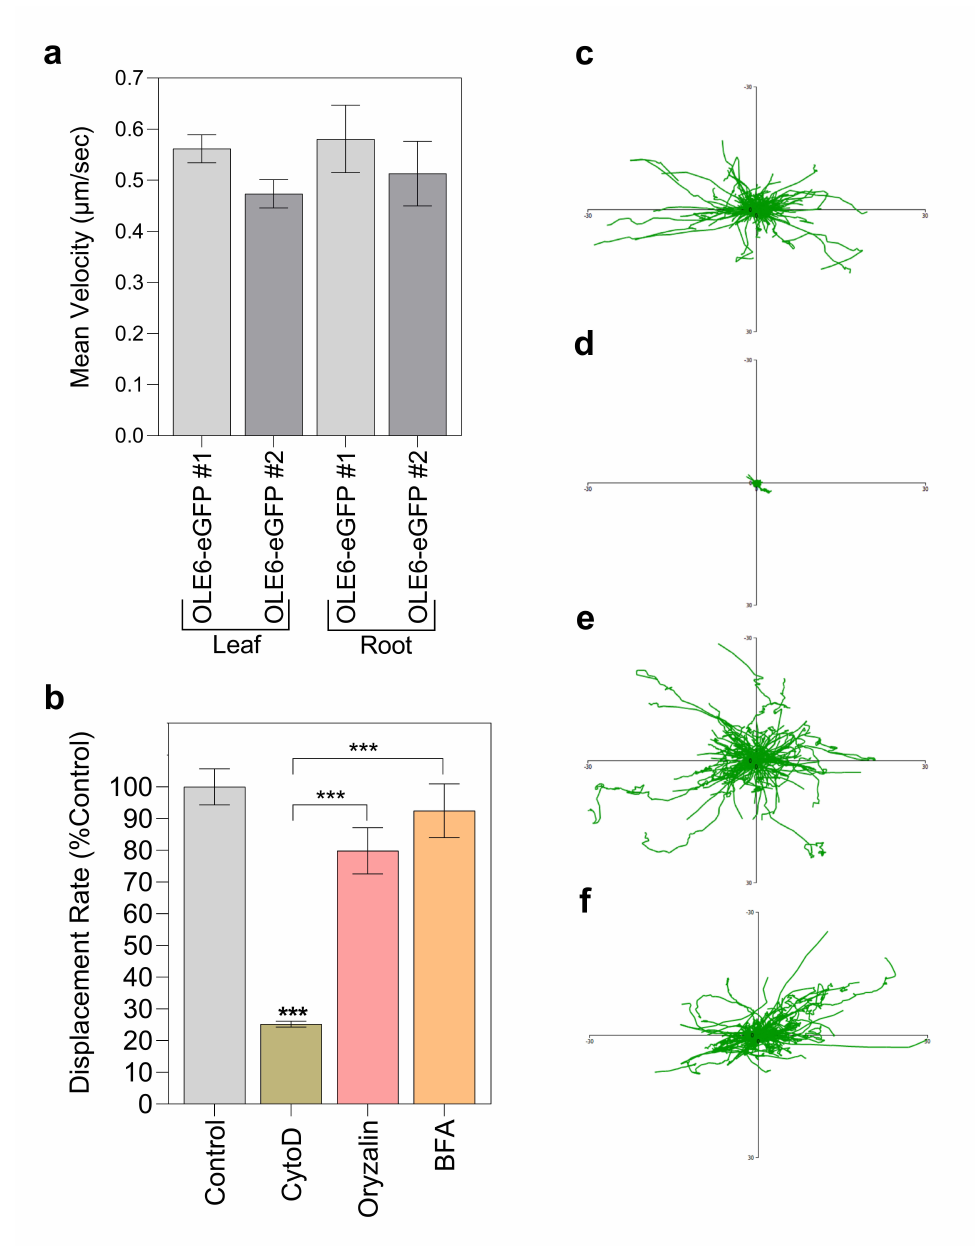
Figure 4. Movement of lipid bodies in PtOLE6-eGFP- overexpressing plants treated with di ff erent pharmacological agents. ( a ) Mean velocity of lipid bodies in leaf epidermal and root cells of two independent PtOLE6-eGFP -overexpressing lines OLE6-eGFP # 1 and OLE6-eGFp # 2 ( ± SE). ( b ) Mean displacement rates of the lipid bodies in leaf epidermal cells of OLE6-eGFP #1 treated with the indicated pharmacological agents and expressed as percentages of the control treatment (0.45 µ m / s) ( ± SE). ( c – f ) Representative tracks of lipid bodies present in control ( c ), cytochalasin D ( d ), oryzalin ( e ), and brefeldin ( f ) treated plants in a time serie, obtained with the CLSM and plotted to a common origin. Asterisks indicate significant di ff erences compared to control and between treatments (*** p <